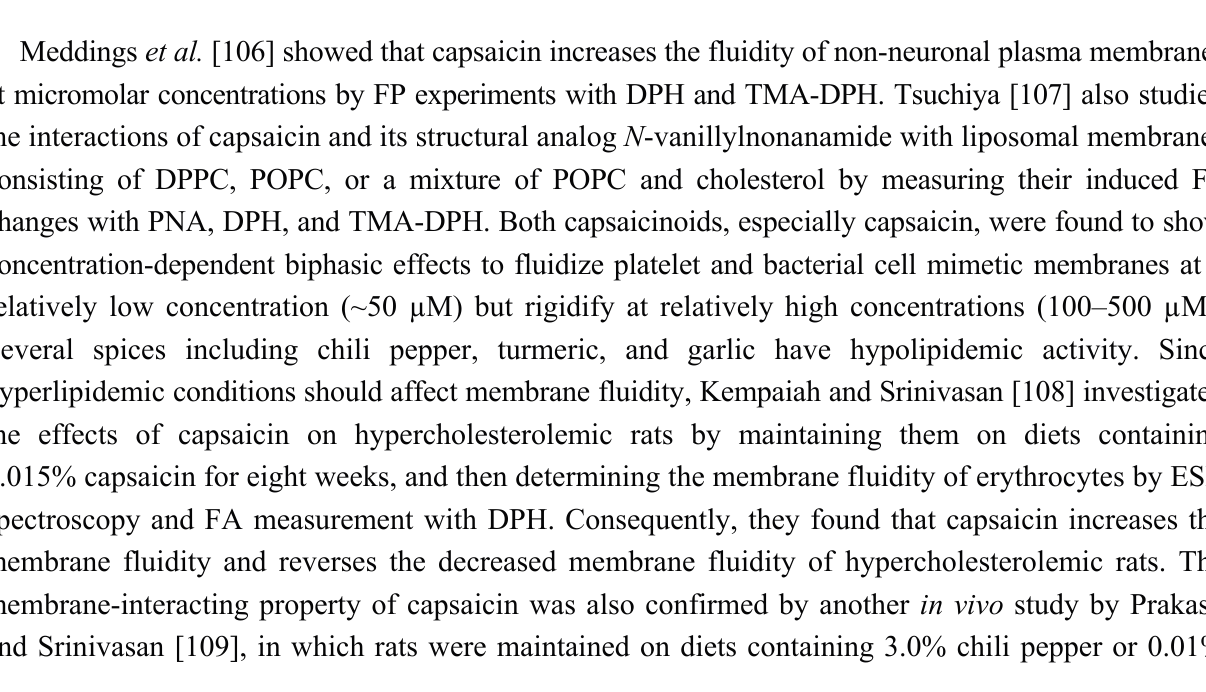
Figure 4. Structures of membrane-interactive